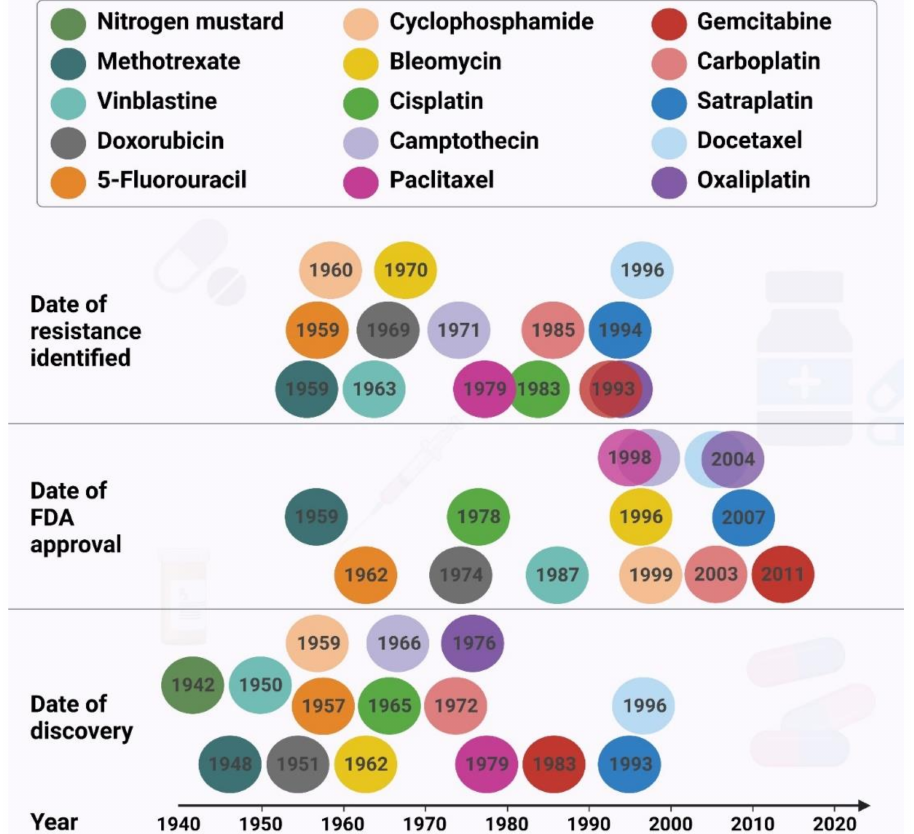
Figure 2. The timelines of chemotherapeutic agent discovery, date of approval by the Food and Drug Association of the United States of America, and the approximate date the resistance was